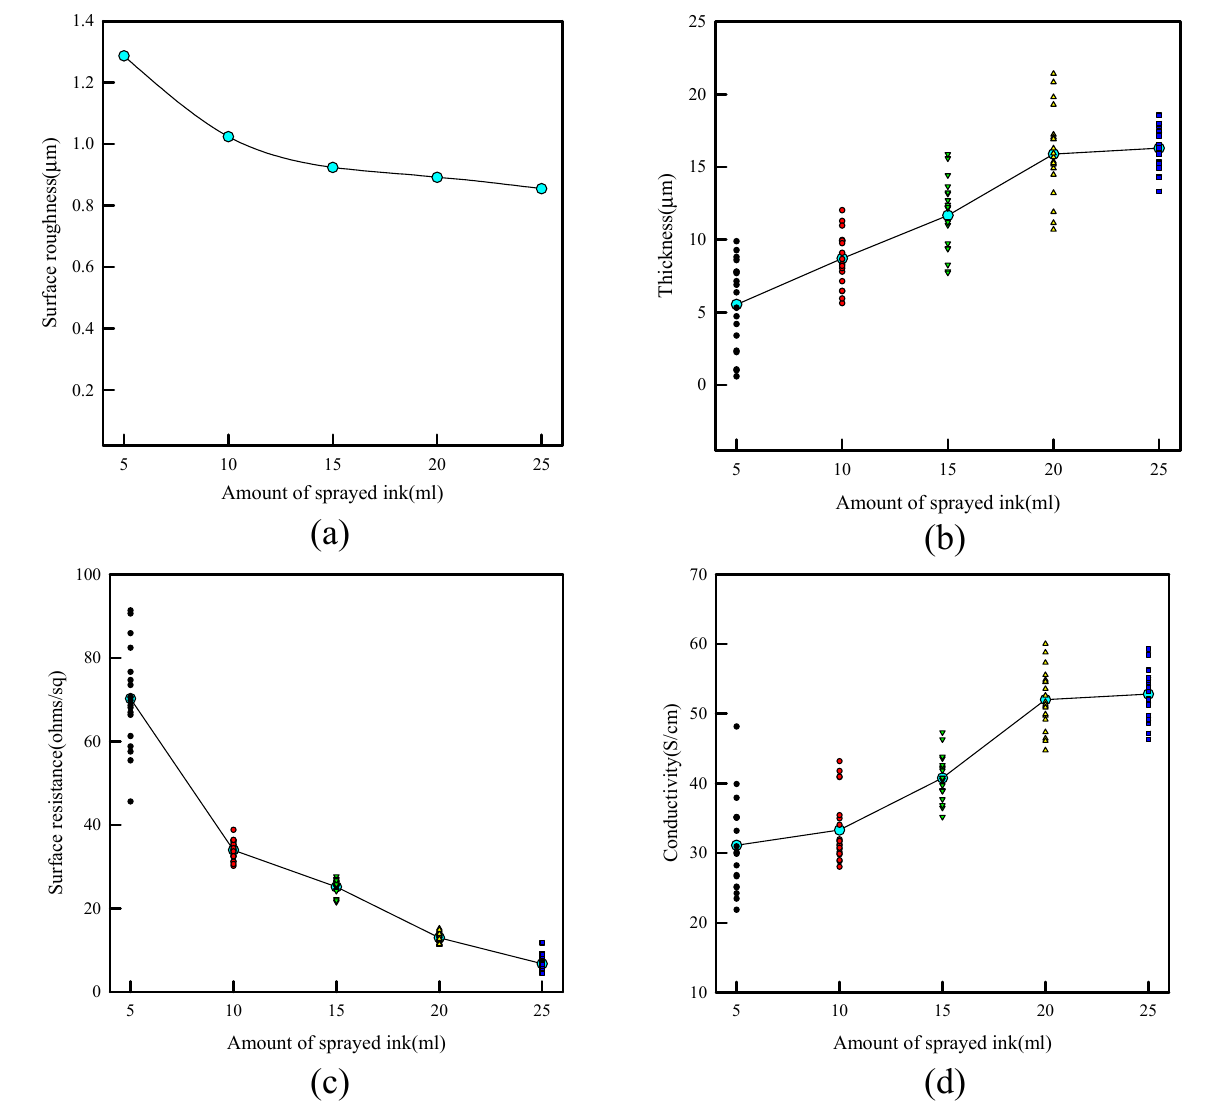
Figure 6. Total properties according to amount of sprayed ink: ( a ) surface roughness, ( b ) thickness, ( c ) surface resistance, and ( d ) conductivity.